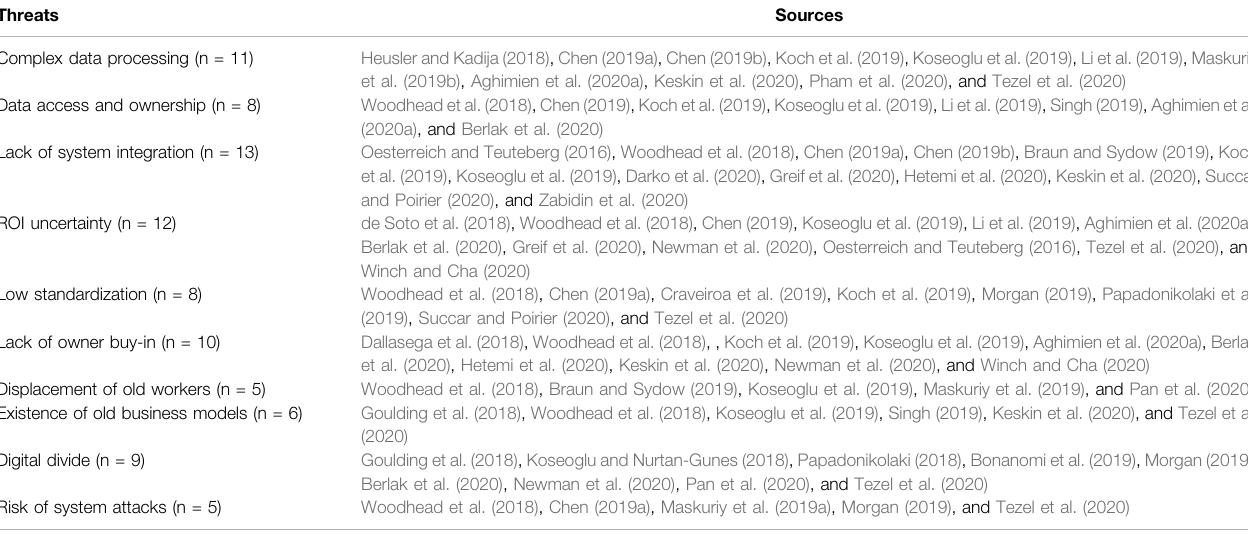
TABLE 5 | Summary of inductive literature on barriers to DT in construction.